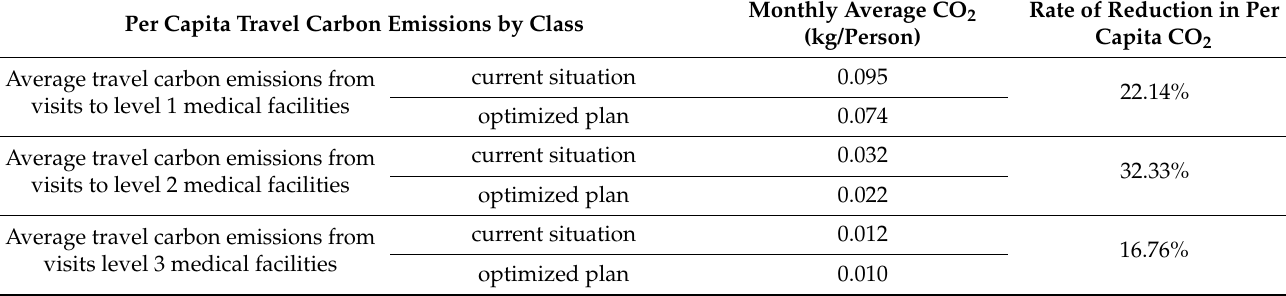
Table 6. Comparison of per capita carbon